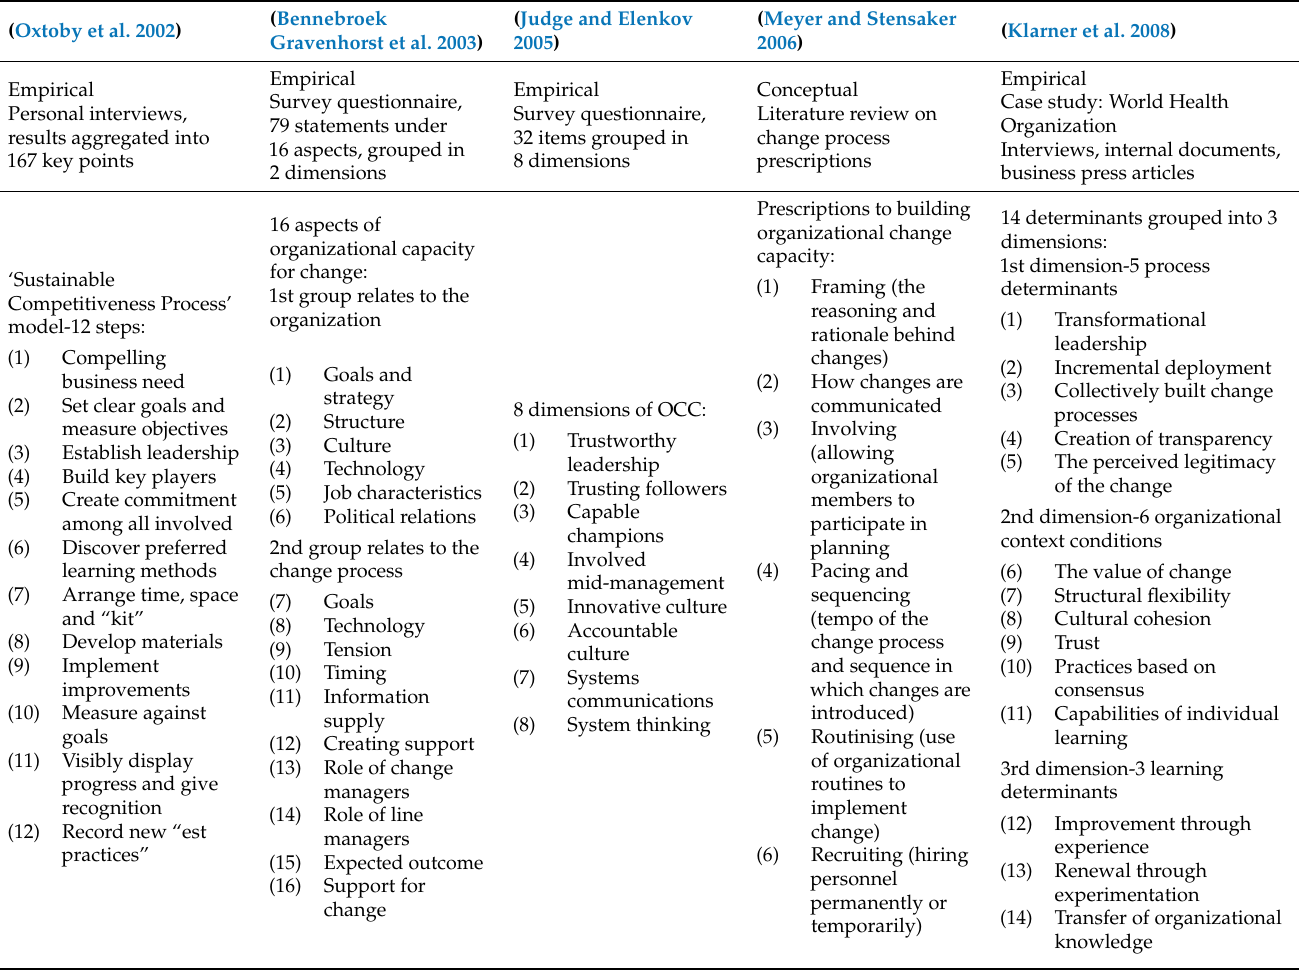
Table A1. Dimensions of organizational capacity for